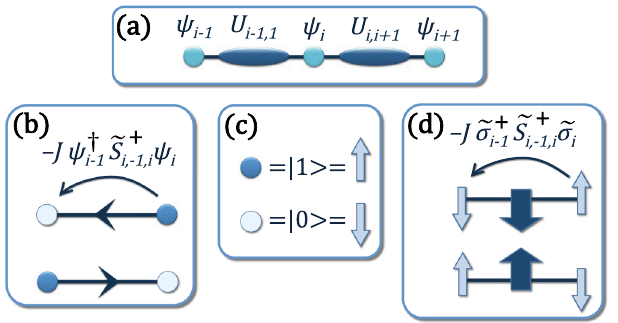
FIG. 1. (a) Lattice gauge theory. Fermions with annihilation , living on lattice sites i , couple to gauge fields, operators c i , living on links i , i þ 1 . (b) A represented by the operators U i;i þ 1 on fermion tunnels fromsite i to i (cid:1) 1 andflips thegaugefield ~ S i (cid:1) 1 ;i the link in between. (c) A filled (empty) bullet denotes an occupied (empty) site, which are mapped by the Jordan-Wigner transforma- tion to the pseudospin up (down) state. (d) The tunneling process of panel (b), expressed in spin